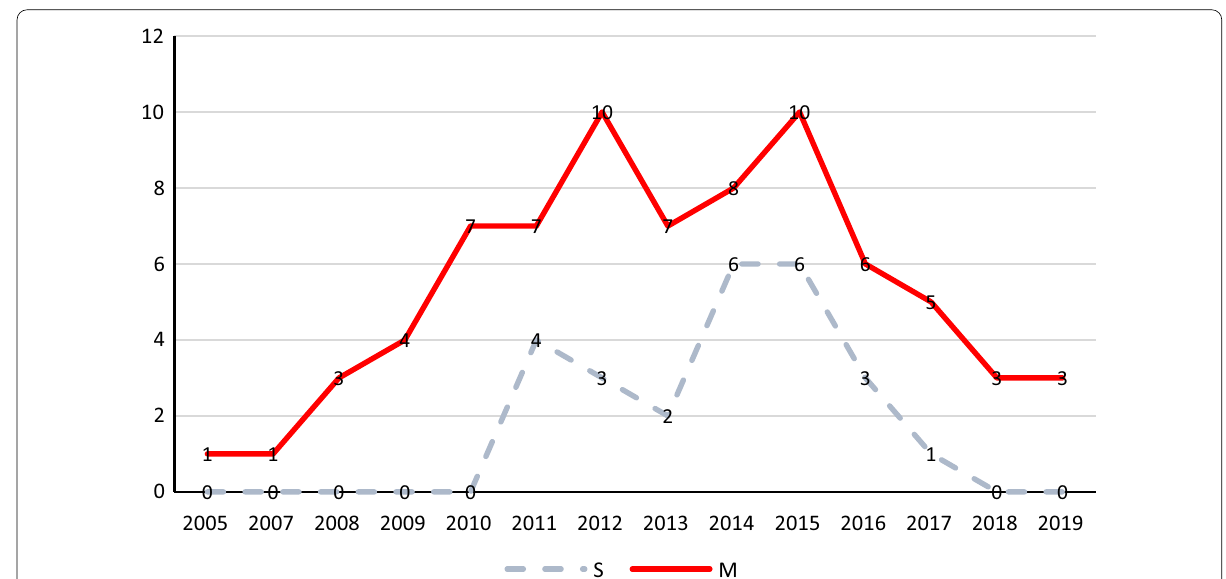
Fig. 5 Publication distribution by disciplinary content coverage over the years. (Note: S